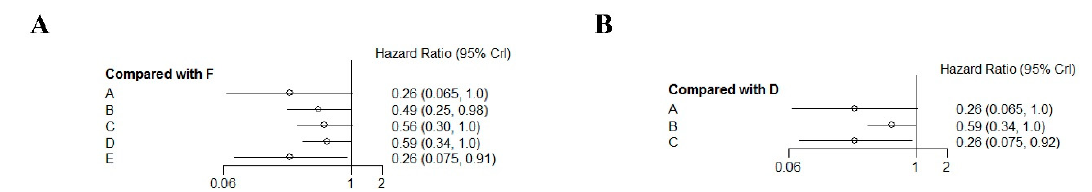
Figure 6. Hazard ratio and 95% credible intervals relative to control. HR < 1 means the regimen is better compared to the control. ( A ) All studies. A: MMC 20 mg + Ara-C 200 mg (maintenance). B: MMC 10 mg (induction). C: Epirubicin 20 mg (induction). D: MMC 40 mg (single instillation). E: Pirarubicin 30 mg (single instillation). F: Control. ( B ) Prospective controlled trials. A: MMC 20 mg + Ara-C 200 mg (maintenance). B: MMC 40 mg (single instillation). C: Pirarubicin 30 mg (single instillation). D: Control.